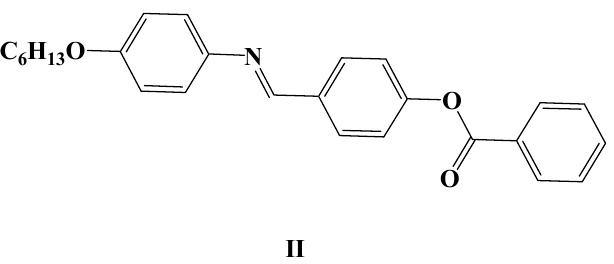
Figure 6. The previously laterally neat analogous, II.